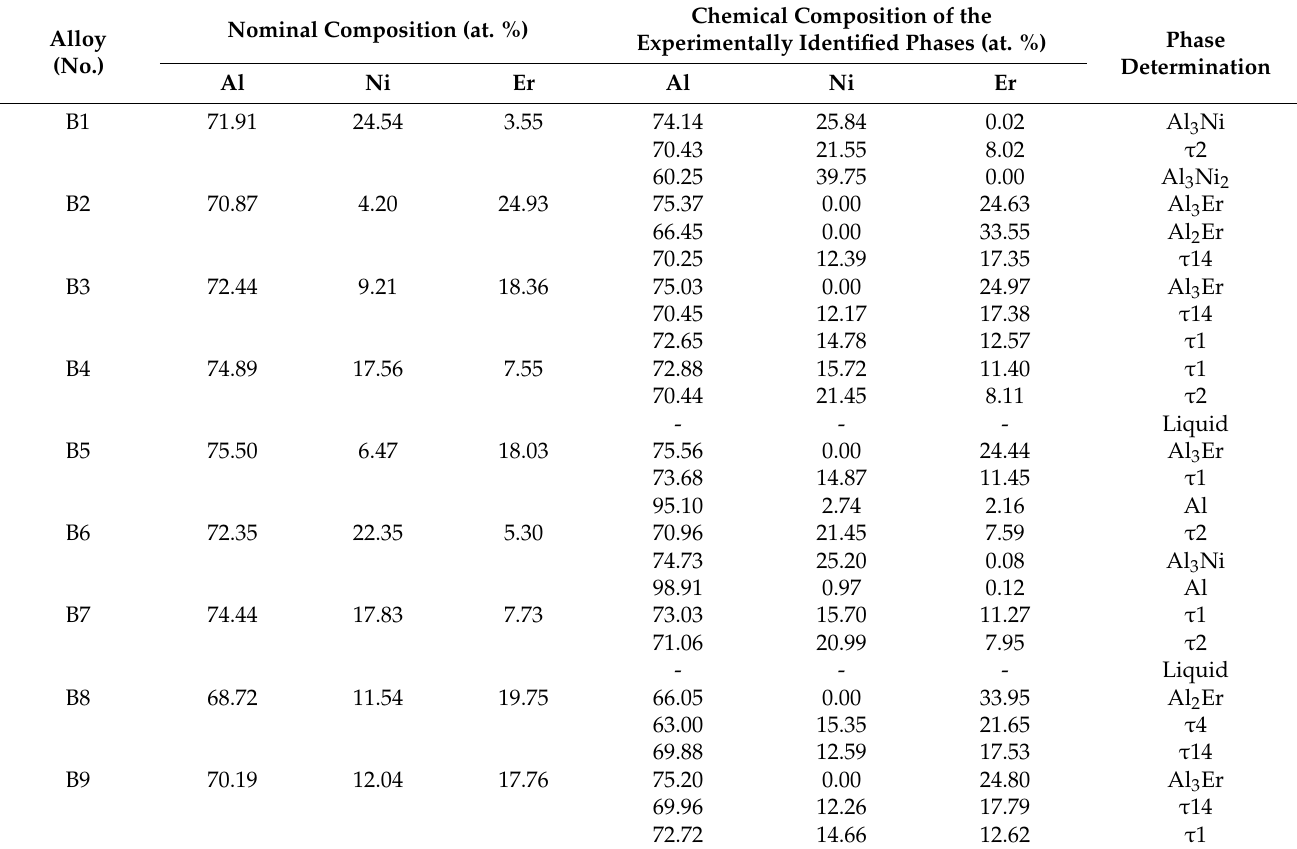
Table 3. Constituent phases and nominal compositions in the annealed alloys at 700 ◦ C.